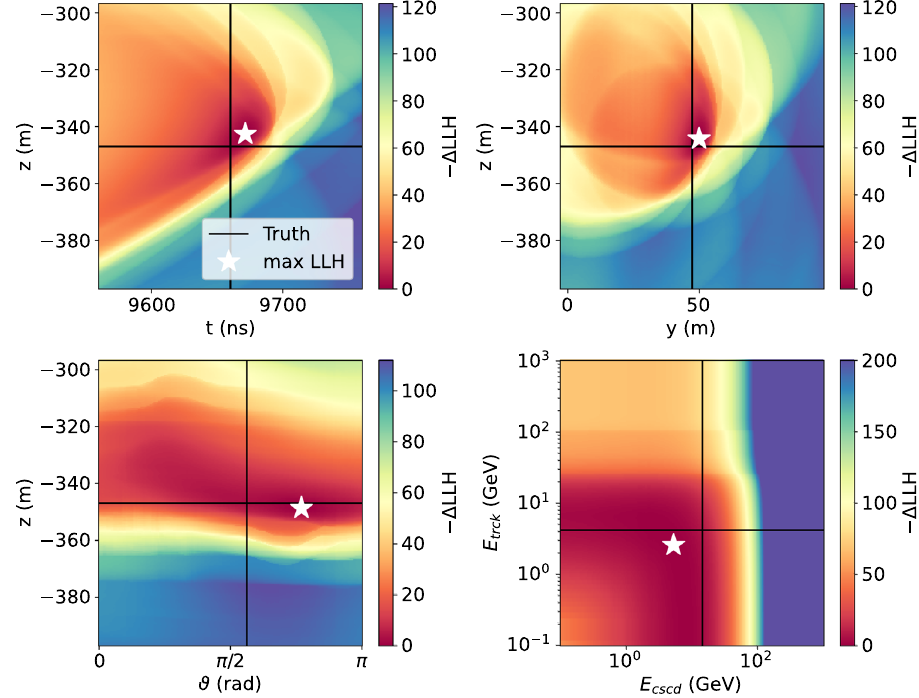
scale). The first row contains almost exclusively direct (unscattered) photons, and hence the left most plot in that row has almost all photons in the bin of direct line of sight, and the Cherenkov table contains a sharp ring. The subsequent rows are at later times and contain more and more scattered light resulting in diffusion. The last column showing the percentage difference between compression and original exhibits the largest deviations in the right half, where light is back-scattered and statistics are very low